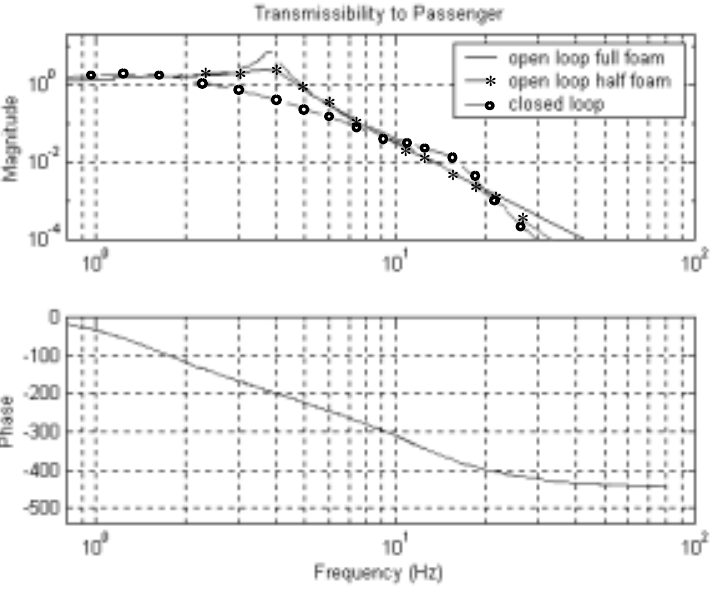
Fig. 5. Simulated frequency response demonstrating the effects of active control on the seat